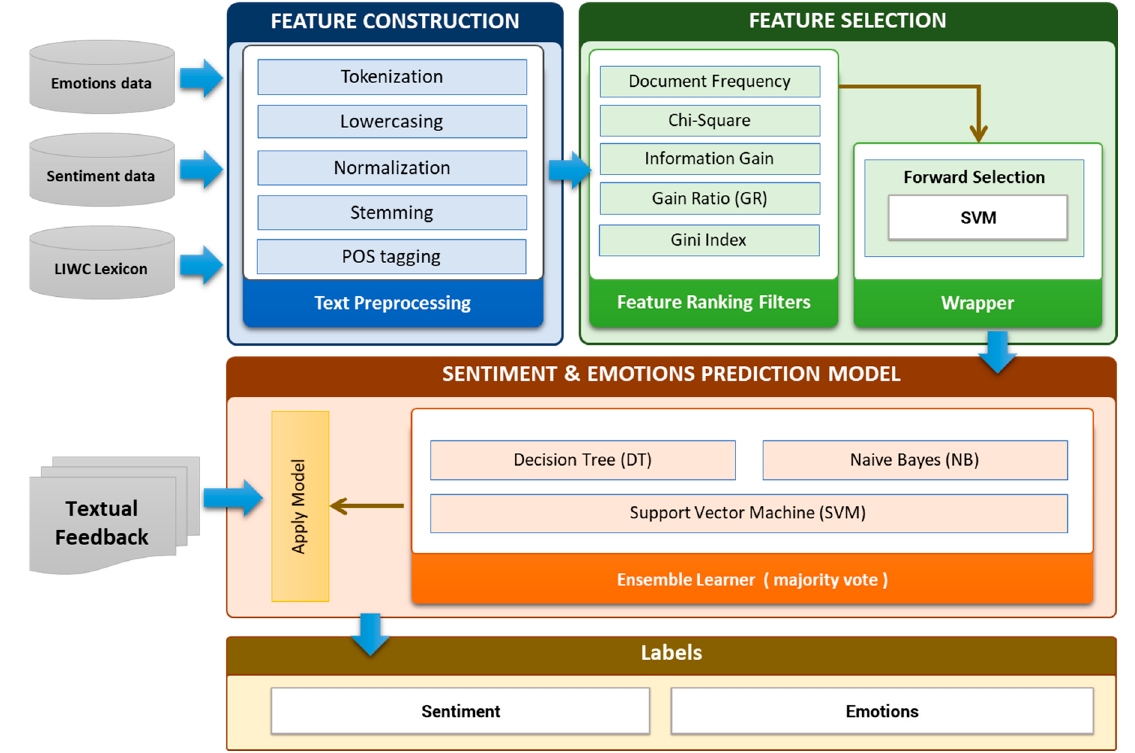
Figure 8. The workflow of sentiment and emotion analyzer.